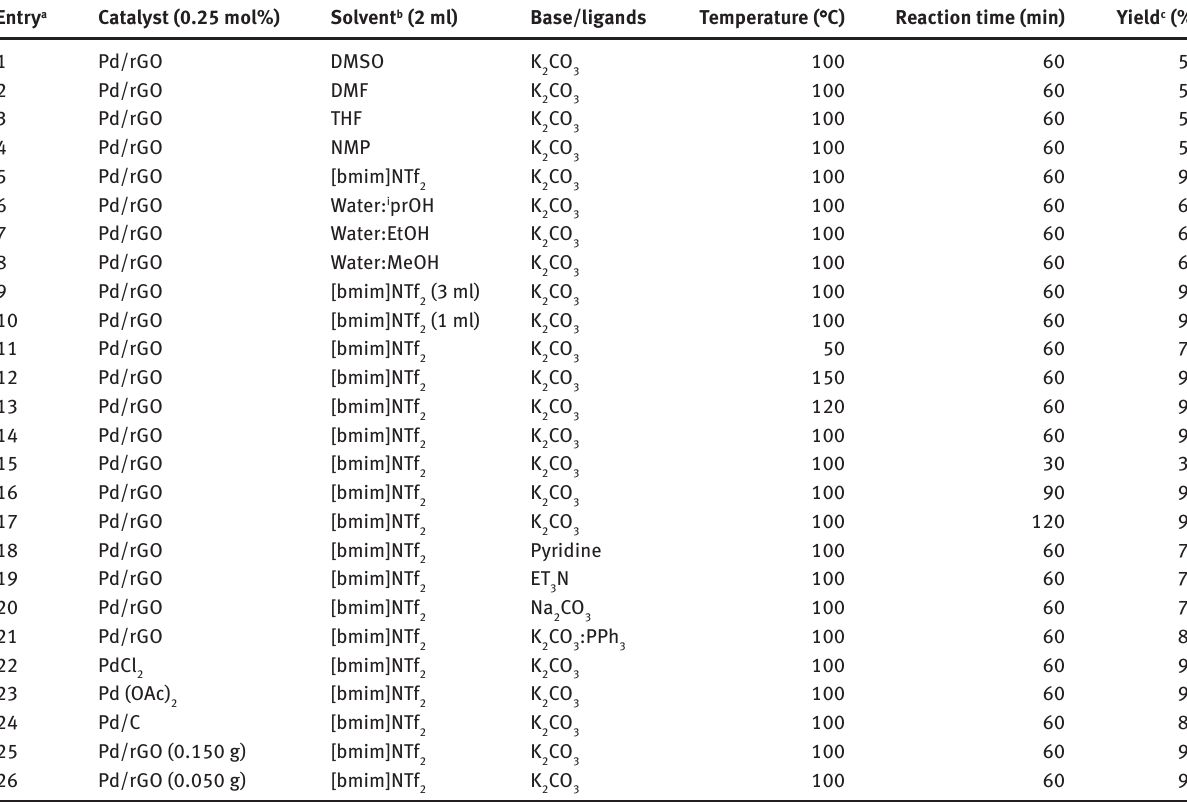
Table 1: Catalyst optimization for Suzuki reaction.